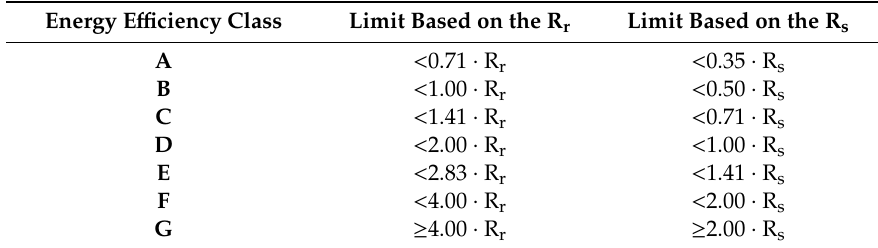
Table 2. The limits value of energy e ffi ciency classes [28].